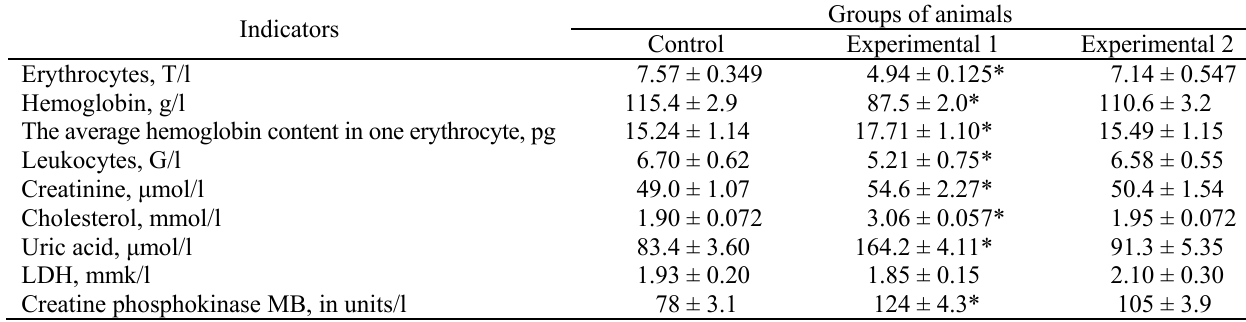
Morphological and biochemical indices of blood of rats in experimental modeling of heart failure and action of the preparation “Bendamin” (M ± m, n = 6)